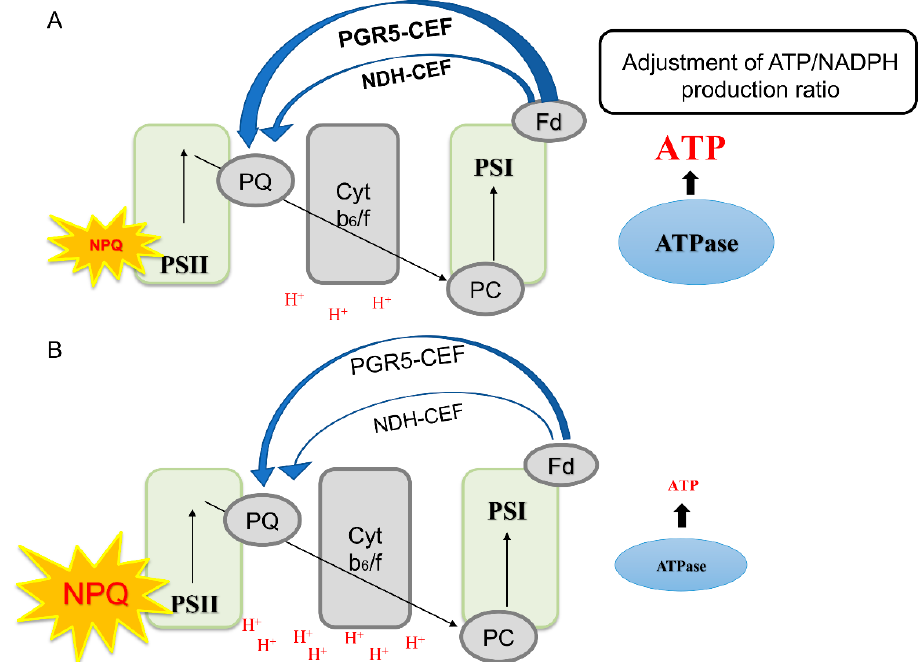
Figure 6. Different photoprotection mechanisms were induced in leaves ( A ) and bracts ( B ) from the same cotton plant. ( A ) The cotton leaves mainly depend on cyclic electron to optimize ATP/NADPH. ( B ) The cotton bracts mainly rely on the dissipation of excess excitation energy as heat driven by a proton gradient across the thylakoid membrane. The thickness of the arrow indicates the strength of the cyclic electron flow; ATP and NPQ font size and boldness reflect the strength of these functions .